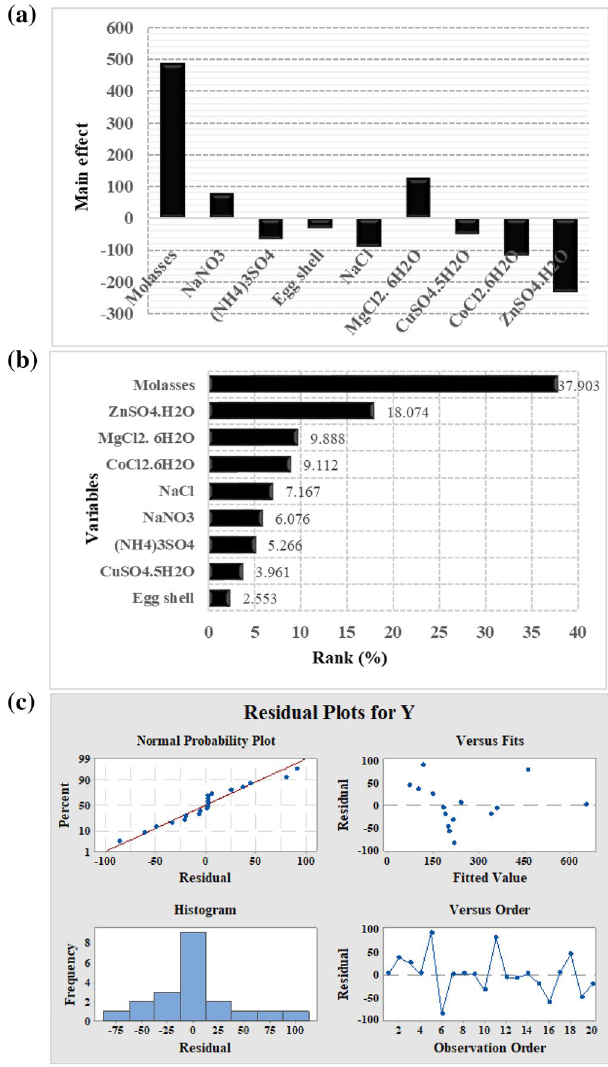
Figure 3. PBD results: (a) main effect of culture variables, (b) Pareto chart illustrating the order and significance of the variables affecting ALP production by Lysinibacillus sp. strain APSO in a ranking percentage from 2.553 to 37.903, and (c) normal probability plot of the residuals for ALP production determined by the first-order polynomial